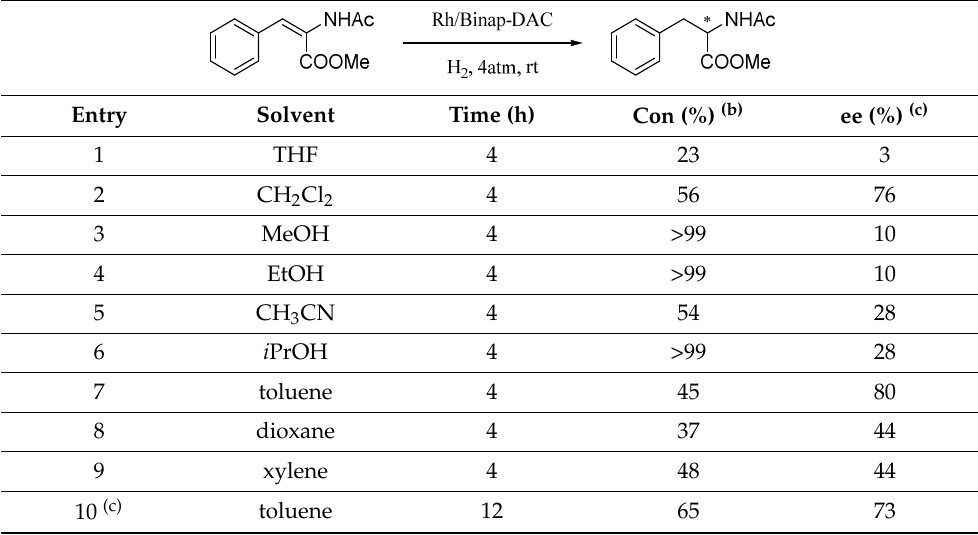
Table 1. Solvent Screening for Rh-Catalyzed Asymmetric Hydrogenation of 2-acetamido-3-phe- nylprop-2-enoate [a].